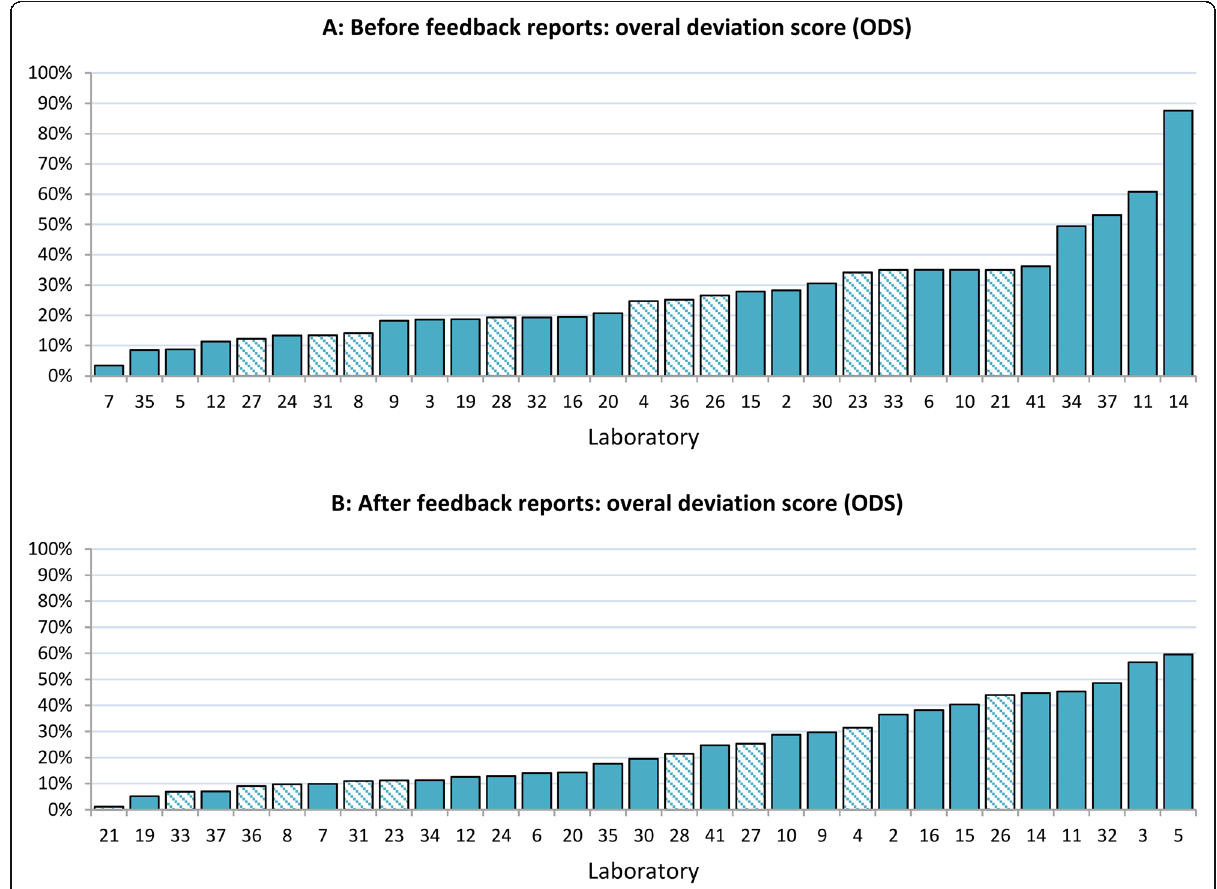
Fig. 2 Inter-laboratory ( n = 31) variation in histologic grading of ductal carcinoma in situ (DCIS) of the breast ( a ) ( n = 1493) and after feedback reports ( b ) ( n = 1461). Each bar represents the overall deviation score (ODS) per laboratory. Laboratory numbers for A & B correspond. All laboratories are ranged from lower to higher ODS. The maximum ODS decreased from 87.7 to 59.6% after feedback. Striped bars